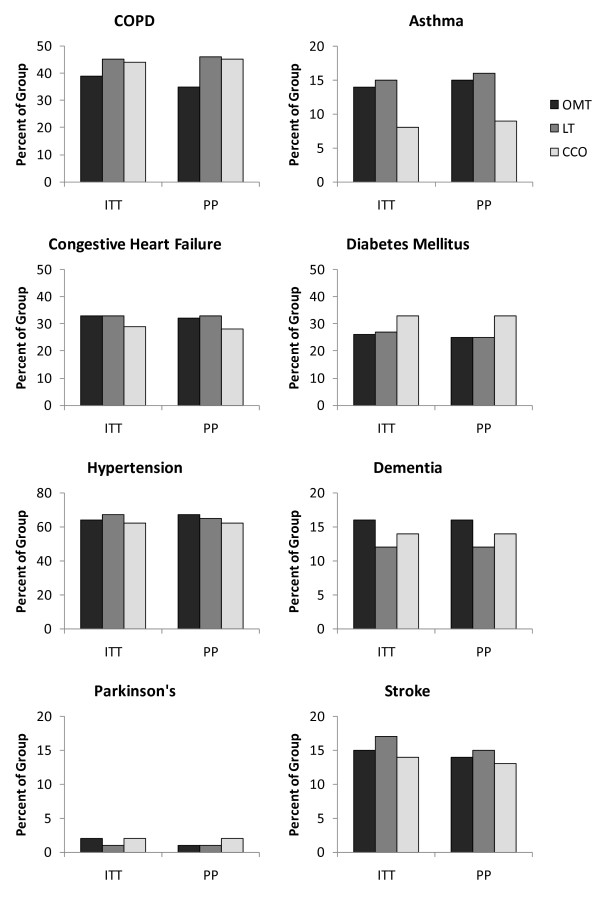
Comparison between intention-to-treat and per-protocol analyses on MOPSE subject comorbidities. ITT = intention-to-treat, PP = per-protocol, OMT = osteopathic manipulative treatment, LT = light-touch treatment, CCO = conventional care only, COPD = chronic obstructive pulmonary disease.